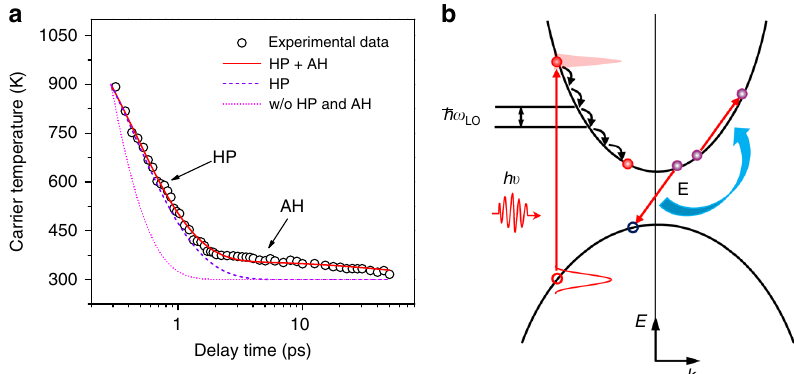
Fig. 3 HC cooling governed by hot-phonon bottleneck and Auger heating effects at carrier densities above 10 19 cm − 3 . a HC cooling dynamics following photoexcitation at 2.48 eV with a carrier density n 0 of 10.4 × 10 18 cm − 3 at RT. Black circles: HC temperature extracted from TA spectra. The lines show the calculated HC cooling dynamics for τ ph = 0.6 ps: with hot-phonon (HP) effect only (violet dashed line); with both HP and Auger heating (AH) effects (bright red line); and without HP and AH effects (magenta dotted line). b Schematic of hot electron relaxation process via LO phonon emission and non- radiative Auger recombination that contributes to further deceleration of hot electron cooling. The same process will also be present for the hot holes (not shown for